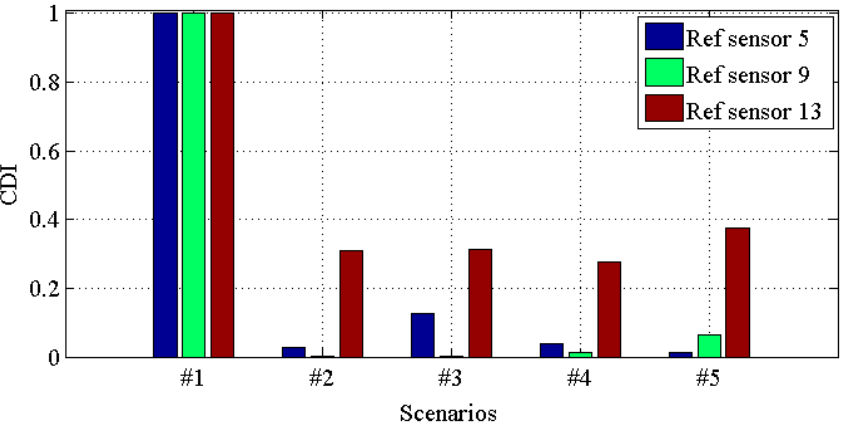
Figure 10. CDI for transmissibilities T(1, :), T(5, :), T(9, :) and T(13, :) with reference sensor 5, 9 and 13 for damage scenario #1 to #5.